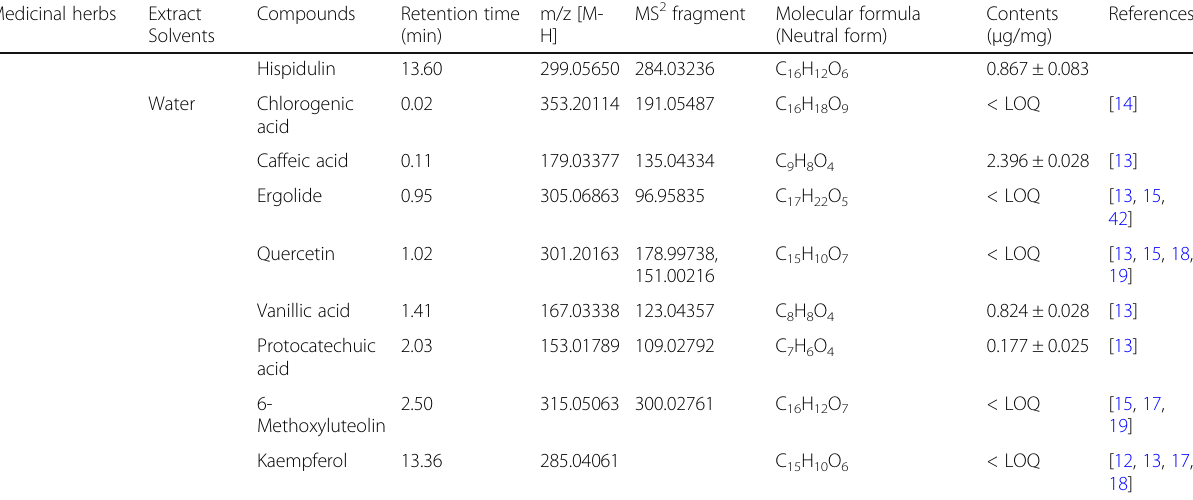
Table 2 Ultra performance liquid chromatography (UPLC)-electrospray ionization (ESI)-Q/Orbitrap tandem mass analysis of medicinal herbs (Continued) Medicinal herbs